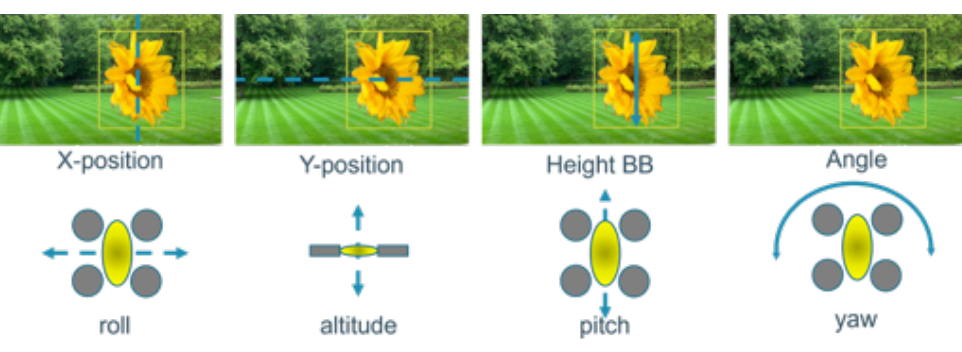
Figure 11. The four properties that our detection model perceives of the flower and their related steering